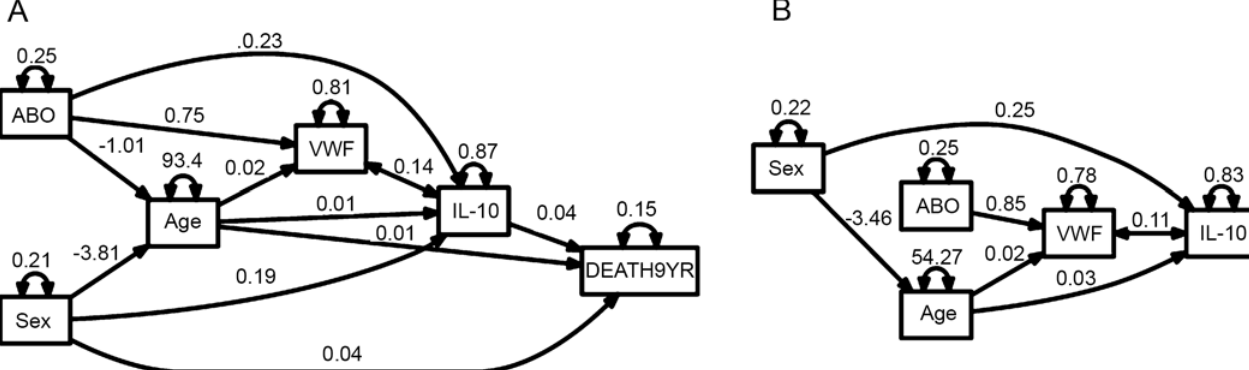
Fig 2. Path analyses in ACS patients (A) and controls (B). Single-headed arrows are direct associations represented by the regression coefficient from multiple regressions. Double-headed arrows above the variables represent residual variance (for endogenous variables) or variance (for exogenous variables). Double-headed arrows between two variables are indirect associations represented by the correlation coefficient. VWF and IL-10 are both standardized. Only significant ( P < 0.05) associations are shown in the figure. Note that age, as a responding variable in the ACS patients, should be regarded as the age of